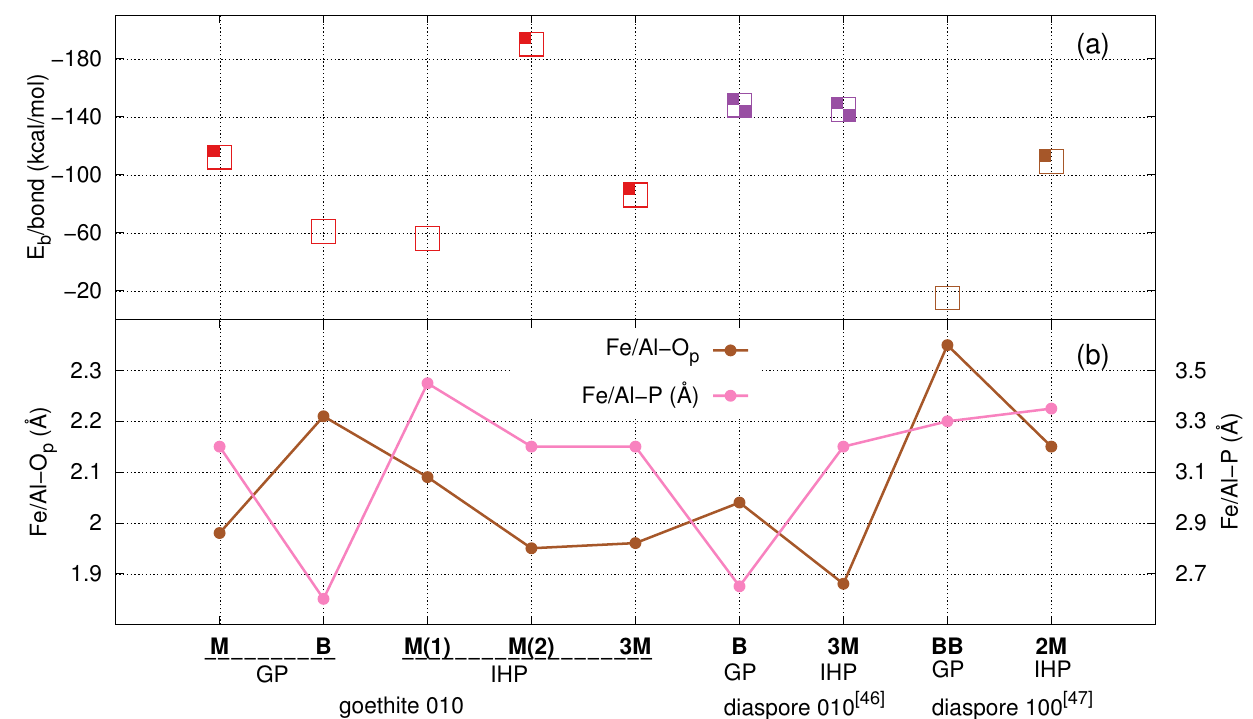
Figure 2. Comparison plot of interaction energies per bond E b ( a ) and Fe–O p , Fe–P distances ( b ). Panels ( a , b ) also contain data for diaspore–IHP/GP–water complexes [47,48]. In the top figure, the number of filled subsquares denote the total number of proton transfers from IHP/GP to surface and center of box denotes the binding energy. The square with zero filled subsquares denotes zero proton transfers from phosphate to the